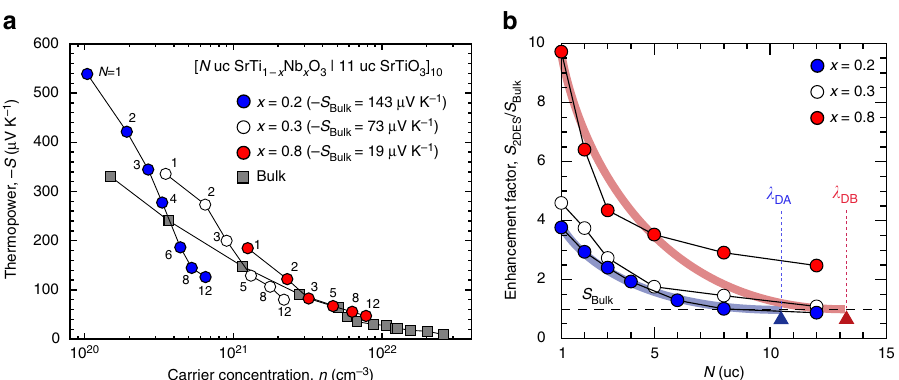
Fig. 4 Two-dimensionality of 2DES: a key to enhance thermopower. a Plots of thermopower of the 2DESs, [ N uc SrTi 1 − x Nb x O 3 |11 uc SrTiO 3 ] 10 superlattices ( x = 0.2, 0.3, and 0.8), versus the carrier concentration ( n ). Compared to bulk values (gray squares), all the 2DESs show an enhanced − S as N is reduced under 3 uc. b Enhancement factors in – S ( S 2DES / S Bulk ) for three sets of 2DESs. For x = 0.2 and 0.3 2DESs, the highest S 2DES / S Bulk values are obtained at N = 1, which are 4 and 5, respectively, while that of x = 0.8 can